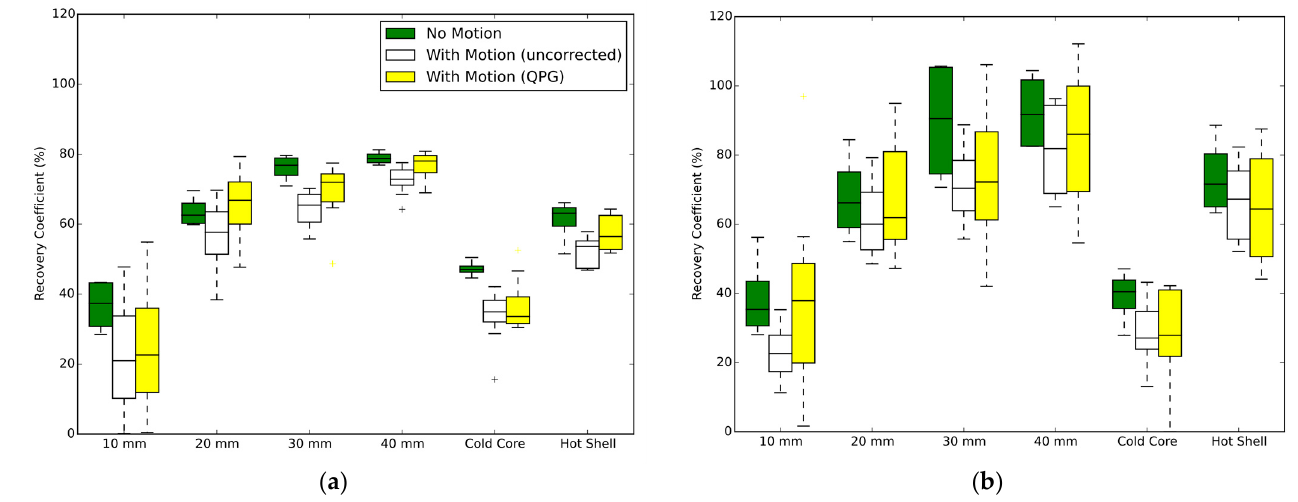
Figure 3. Activity concentration volume histograms for the 30 mm sphere. Each figure part shows the results for no motion, and when motion is present (10–15 mm amplitudes) either with or without quiescent period gating. Data are presented as the average ACVH for this sphere from the four phantom experiments on each scanner. ( a ) Discovery 710 (BPL reconstruction); ( b ) Biograph mCT.